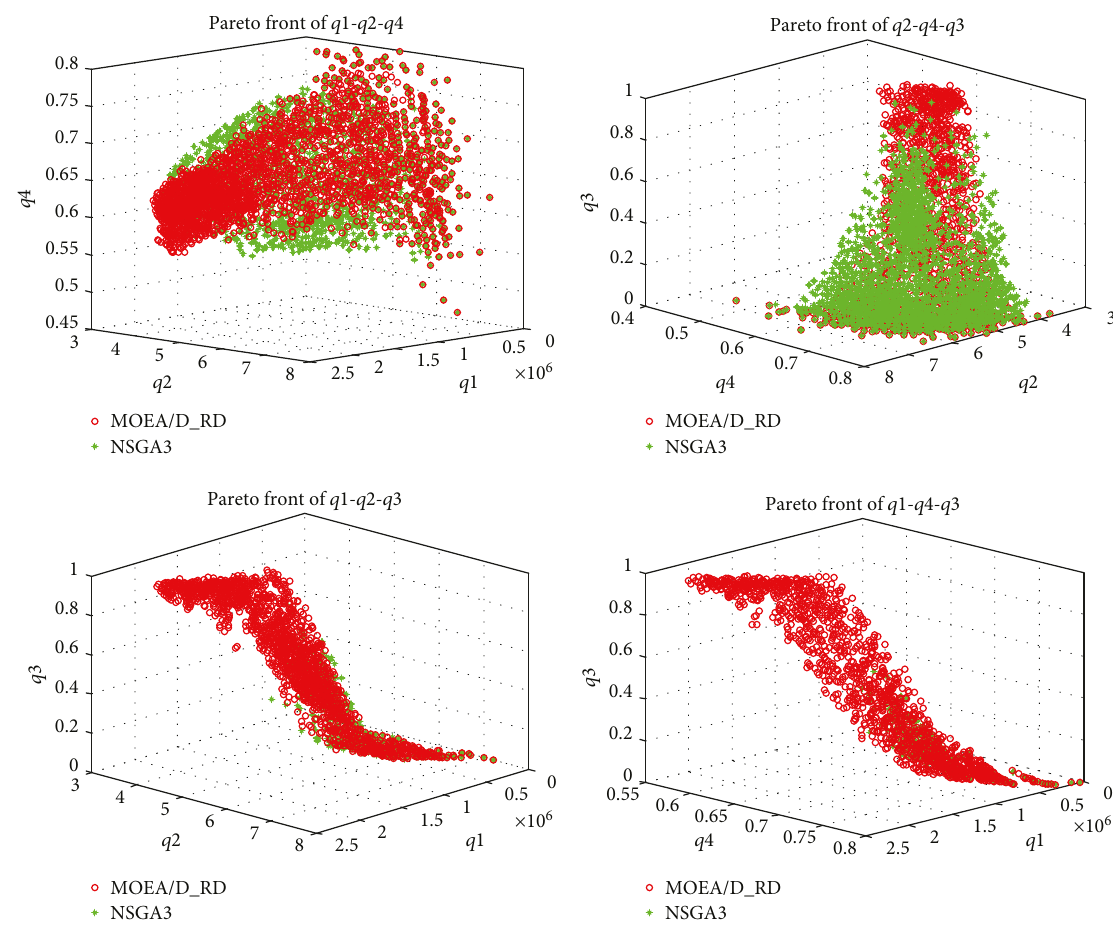
Figure 15: Comparison of PF between MOEA/D_RD (red circle) and NSGA3 (green ∗ ) for 3-objective